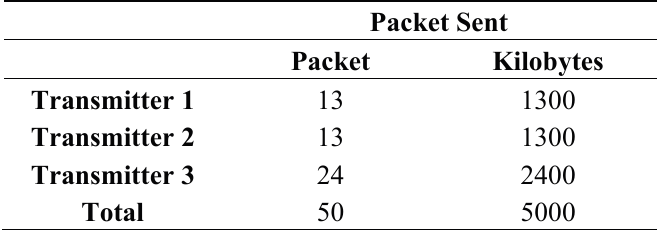
Table 7. Transmission and mobility tests with three transmitters (868 MHz, 0